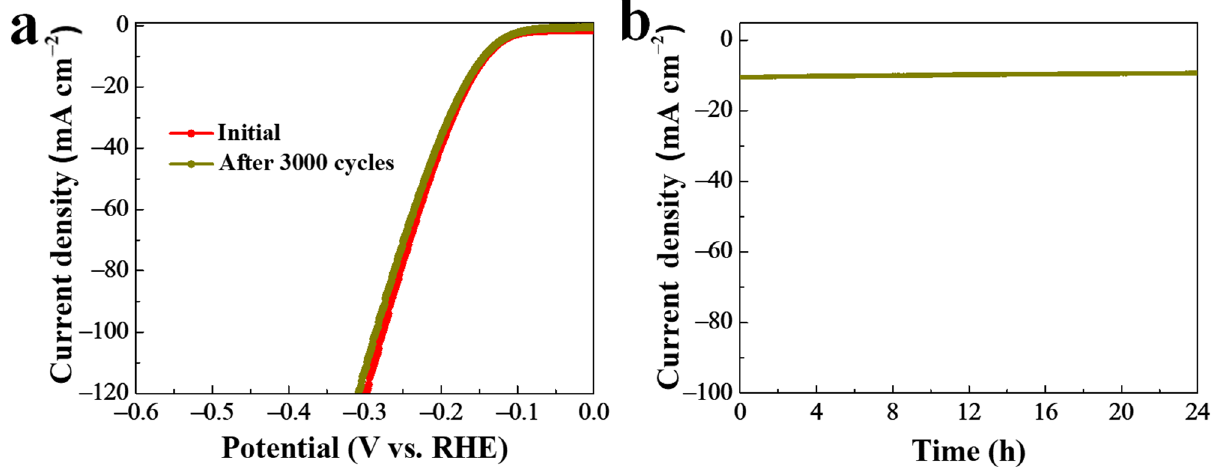
Figure 6. ( a ) Stability of NiSe 2 -MoSe 2 HTs/G after 3000 CV tests. ( b ) I-t test of H-NiSe 2 /MoSe 2 /G under a constant overpotential of 144 mV.